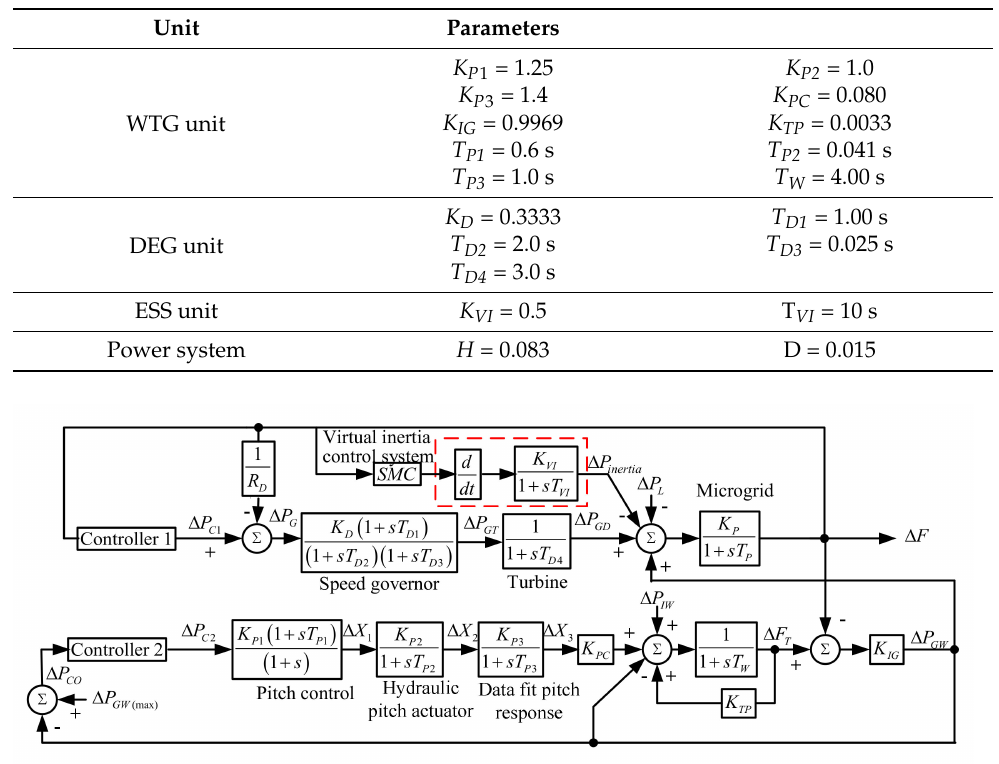
Table 1. HPSREG system dynamic parameters.